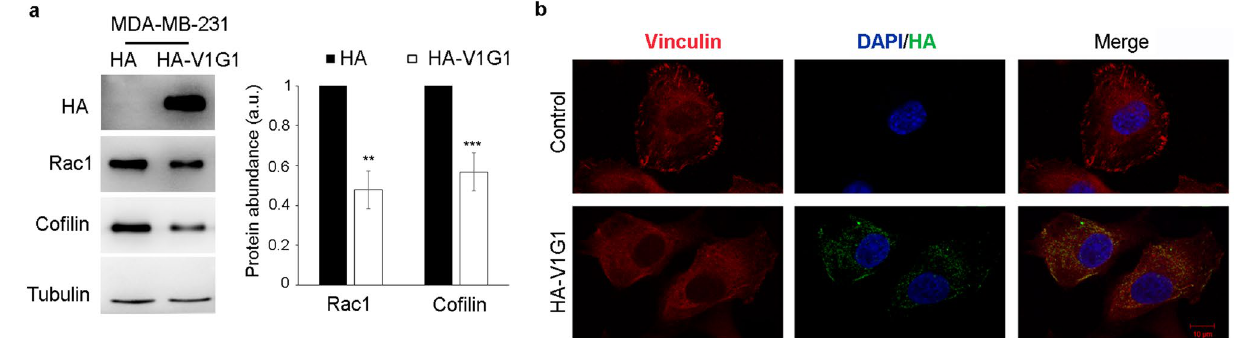
Figure 4. V1G1 overexpression affects RAC1 signaling. ( a ) MDA-MB-231 cells overexpressing HA-V1G1 and control (HA) were lysed and subjected to western blot analysis using anti-HA, anti-RAC1, anti-cofilin and anti-tubulin antibody. Quantification of RAC1 and cofilin protein amount is shown. Data represent the mean ± s.e.m. of at least three experiments. ** p ≤ 0.01; i*** p ≤ 0.001. ( b ) HA-V1G1 overexpressing MDA-MB-231 cells were immunolabeled with anti-HA followed by Alexa488 conjugated secondary antibody to discriminate between cells overexpressing HA-V1G1 and control cells, anti-vinculin followed by Alexa568 conjugated secondary antibody while nuclei were stained with DAPI. Bars = 10 µm.